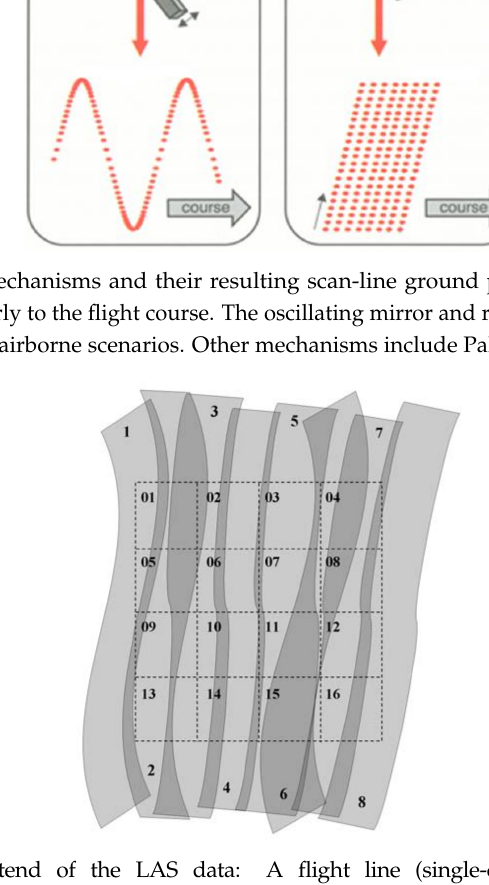
Figure 2. Space extend of the LAS data: A flight line (single-digit numbered) is formed by a set of consecutive scan lines. Odd- and even-numbered stripes are flown in opposite directions. The darker shading shows stripe overlap. Generally, LAS data is organised in tiles (two-digit-numbered rectangles)